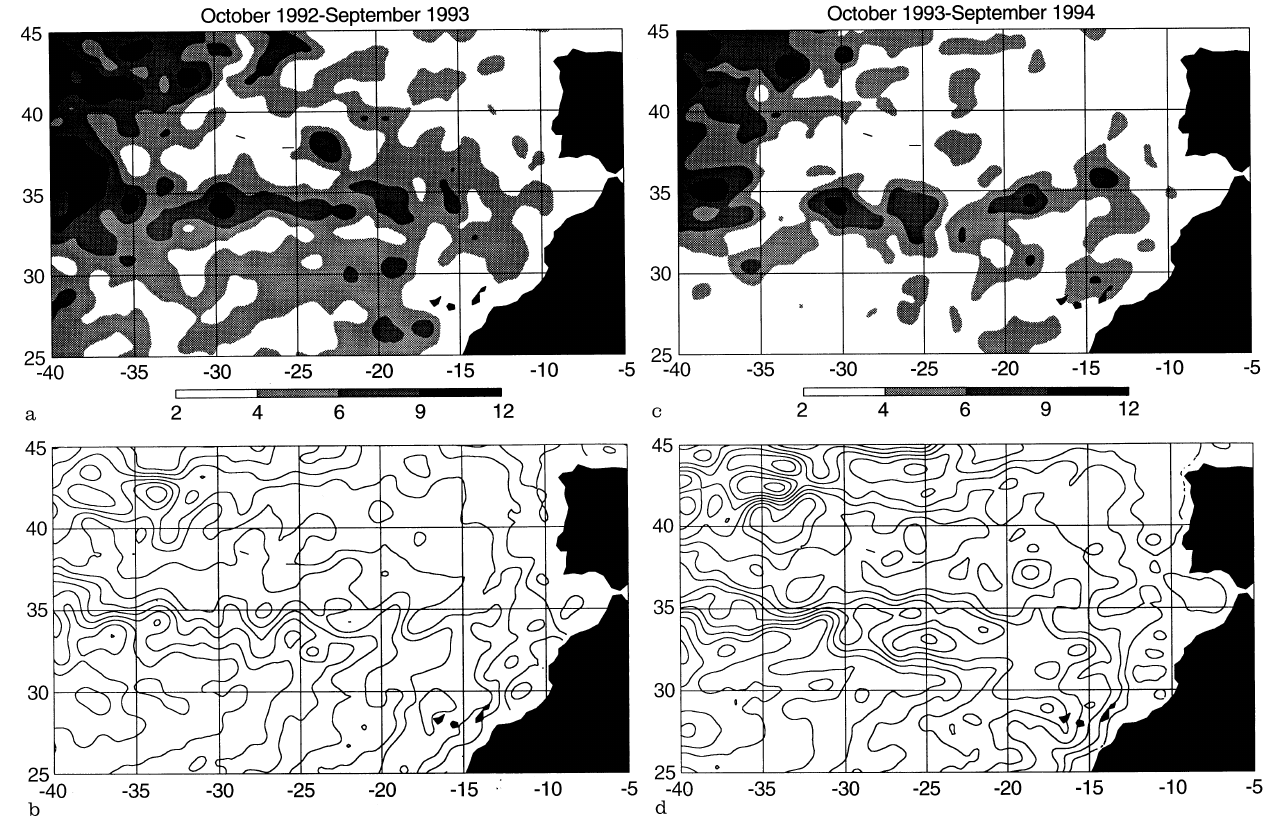
Fig. 10a, b. Same as Fig. 9 for the period from October 1992 to September 1993; c, d same as Fig. 9 for the period from October 1993 to September 1994